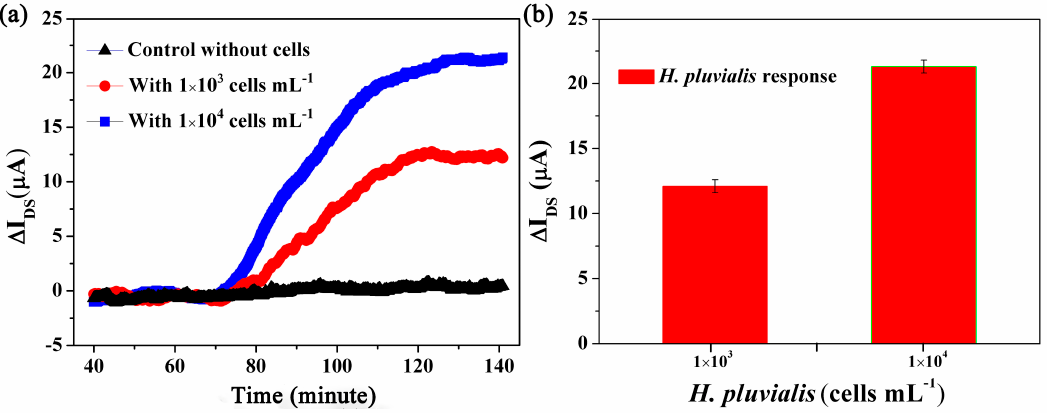
Figure 5. Timeline of the senescent green vegetative phase recorded by OECT. ( a ) In situ OECT response with (red and blue) and without (black) H. pluvialis cells under the light and salt treatment. The real-time transistor current was converted to current change for uniformity, V G = 0.3 V, V DS = 0.1 V. ( b ) Recorded current changes in response to different concentrations of H. pluvialis . Each concentration was repeated five